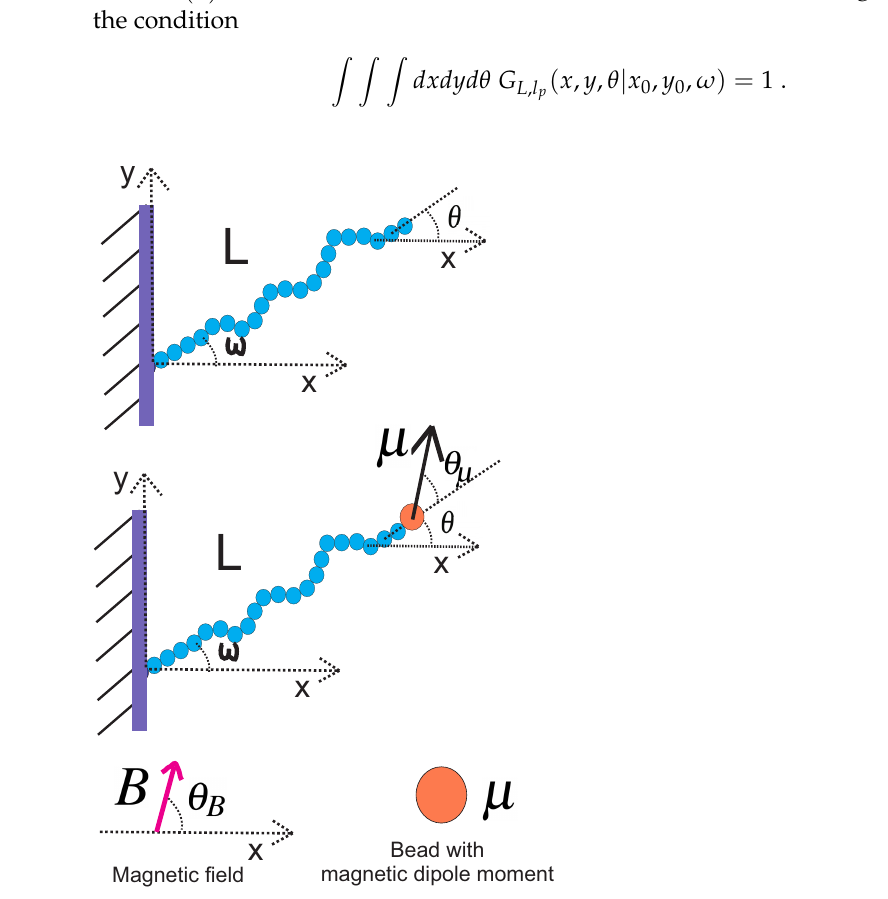
Figure 1. Upper panel : A typical configuration of a rather stiff grafted semiflexible filament in the presence of thermal fluctuations. The persistence length of the filament is l p and it has contour length L . The filament is grafted in a substrate with grafting angle ω . Lower panel : The same filament with one tip attached to a magnetic